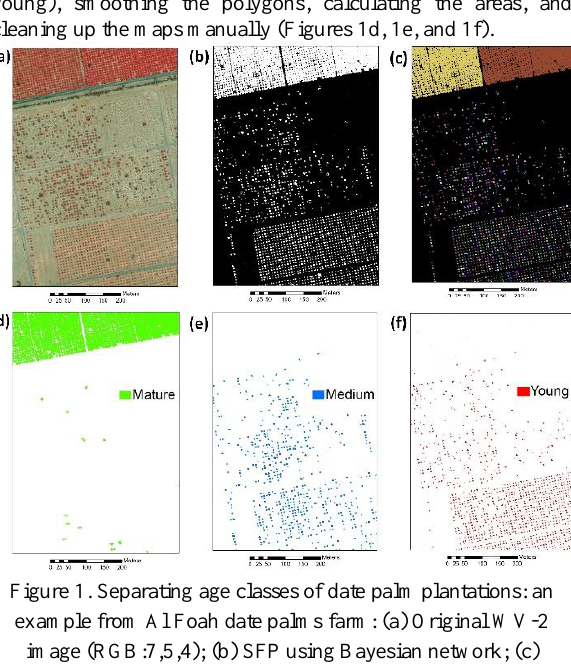
Figure 1. Separating age classes of date palm plantations: an example from Al Foah date palms farm: (a) Original WV-2 image (RGB:7,5,4); (b) SFP using Bayesian network; (c) Threshold and clump applied; (d) Mature palms layer; (e) Medium palms layer; and (f) Young palms